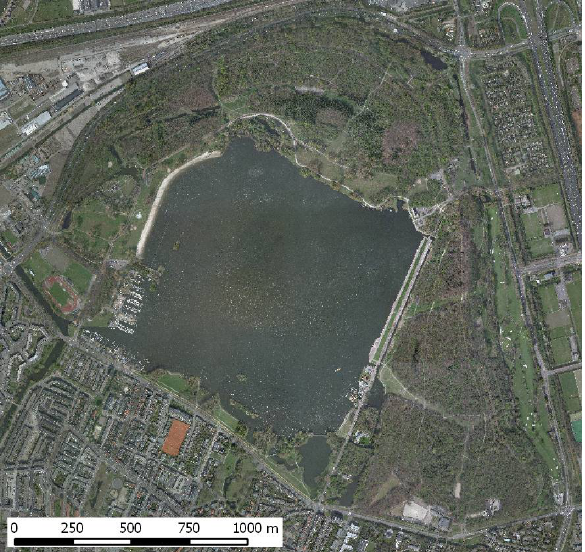
Figure 1: Aerial image of Kralingse Bos (Source: Municipality of Rotterdam)